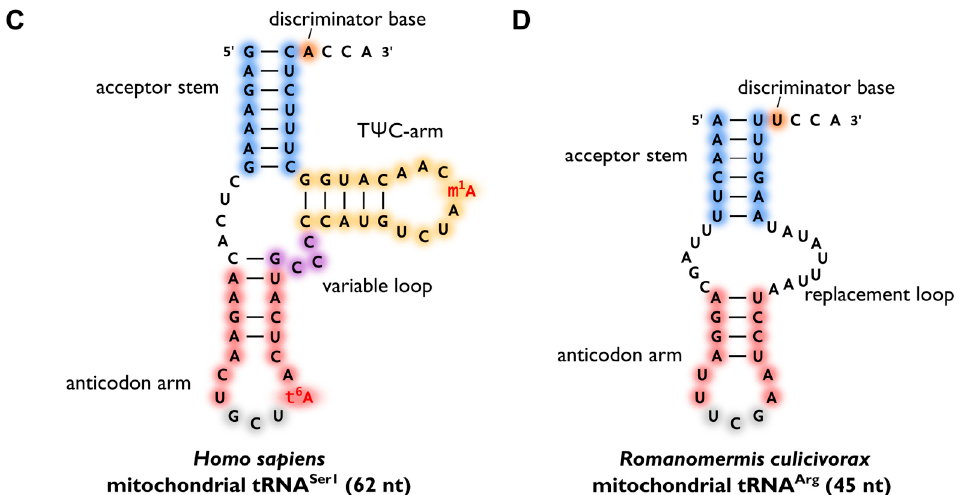
Figure 1. Variability of transfer RNA (tRNA) structures. ( A ) The canonical cloverleaf secondary structure of cytosolic tRNA Phe from S. cerevisiae is shown with acceptor stem (blue), D-arm (green), anticodon arm (red), variable loop (purple) and T Ψ C-arm (yellow). The anticodon is labeled in grey, the discriminator base in orange and post-transcriptional modifications in red. Grey dashed lines indicate tertiary interactions based on structural data [11]. Base numbering corresponds to Sprinzl et al. [25] and length of the RNA is indicated in parenthesis; ( B ) The L-shaped tertiary structure of the cytosolic tRNA Phe from S. cerevisiae . Protein Data Bank entry (PDB): 1EHZ [11]. The acceptor domain is composed of stacked T-arm and acceptor stem, whereas D- and anticodon arm form the anticodon domain. The region where both domains come together and interact with each other via tertiary base pairing is also called elbow region; ( C ) Secondary structure of human mitochondrial tRNA Ser1 , which lacks the whole D-arm [26]; ( D ) Secondary structure of the mitochondrial tRNA Arg from the nematode Romanomermis culicivorax , which lacks both D- and T-arm. Instead, we find a so-called replacement loop. It represents the shortest tRNA found in vivo [21].